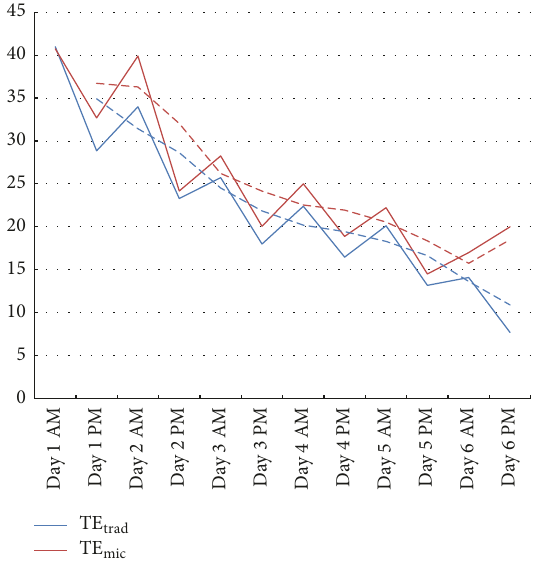
Figure 4: Postoperative mean pain scores (“pain during swallow- ing”) measured in the morning and afternoon by means of a visual analog scale (0–100). Dotted lines: trend line sliding